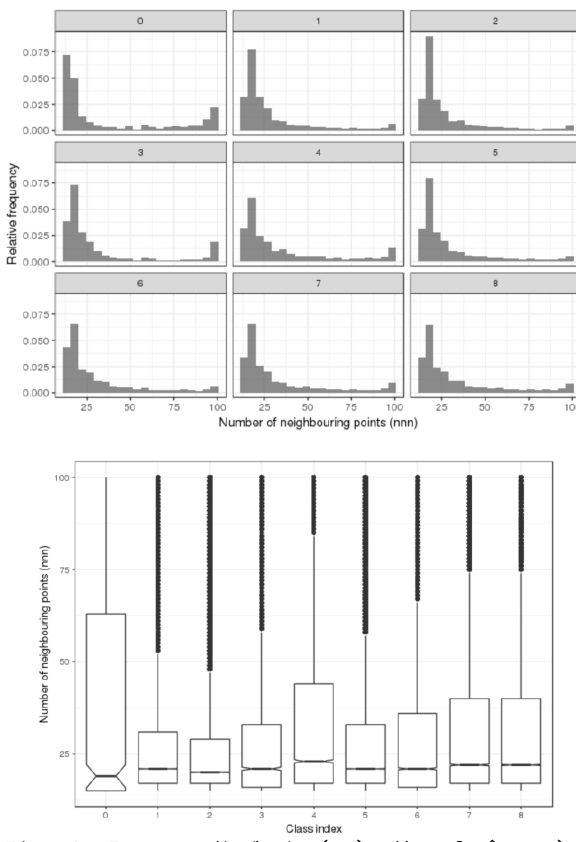
Figure 2. Frequency distribution (top) and box plot (bottom) of nnn values, found with minimum entropy, for each class (see Table 1 for class labels).